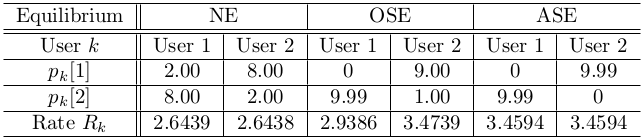
Table from the paper: Self-Optimized OFDMA via Multiple Stackelberg Leader Equilibrium
Table text:
Equilibrium
NE
OSE
ASE
Userk
User1
User2
User1
User2
User1
User2
p k [1]
2.00
8.00
0
9.00
0
9.99
p k [2]
8.00
2.00
9.99
1.00
9.99
0
RateR k
2.6439
2.6438
2.9386
3.4739
3.4594
3.4594